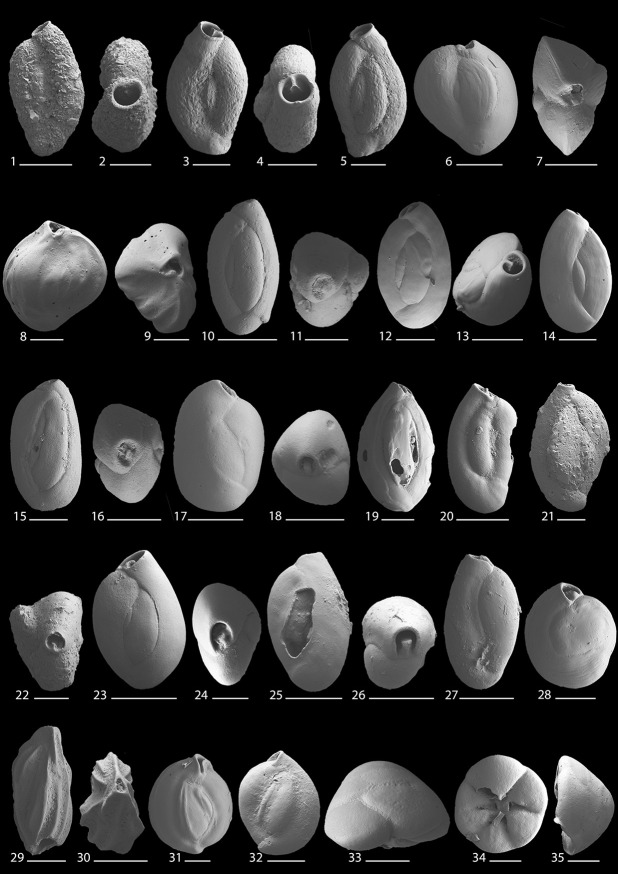
Scanning electron micrographs of benthic foraminifera from the Lagos Lagoon: 1, 2.Trilocularena patensis Closs, 1963; 3–5. Quinqueloculina debenayi Langer, 1992; 6–9. Quinqueloculina cf. Q. cuvieriana d’Orbigny, 1839; 10, 11. Quinqueloculina seminulum Linné, 1758; 12–14. Quinqueloculina cf. Q. seminulum Linné, 1758; 15, 16. Quinqueloculina cf. Q. vandiemeniensis Loeblich and Tappan, 1994; 17, 18. Quinqueloculina sp. 1; 19. Quinqueloculina sp. 2; 20. Quinqueloculina sp. 3; 21, 22. Quinqueloculina sp. 4; 23–27. Triloculina cf. T. verspertilo Zheng, 1988; 28. Pseudotriloculina sp. 1; 29, 30. Edentostomina sp. 1; 31, 32. Miliolinella sp. 1; 33–35. Neoeponides sp. 1. Scale bar is 100 μm for all magnifications, and 50 μm for Figs 11.2, 11.11, 11.15, 11.16, 11.24, 11.31, and 11.32.